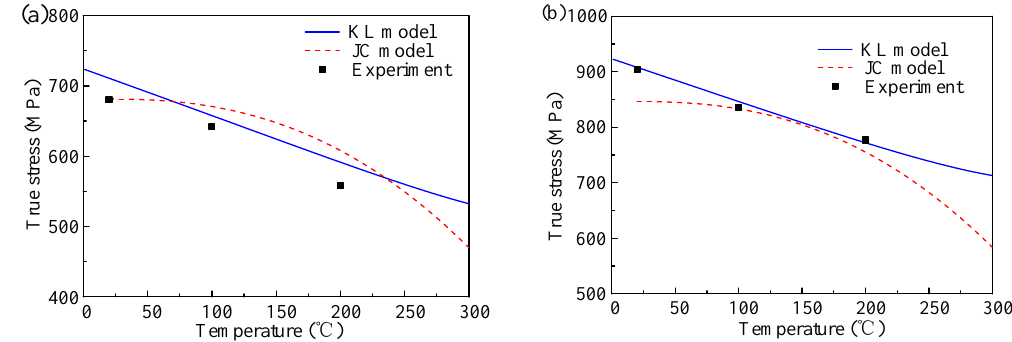
Figure 10. Comparison of temperature effect by JC and KL model at plastic strain 0.03 for different strain rate: ( a ) 0.001 s −1 , and ( b ) 5000 s −1 .